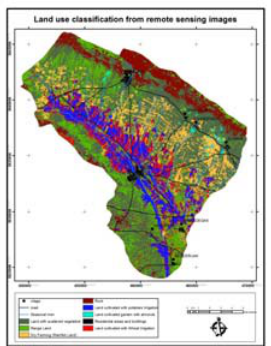
Figure 8: Evaluation of the averages of frequency with the best solution